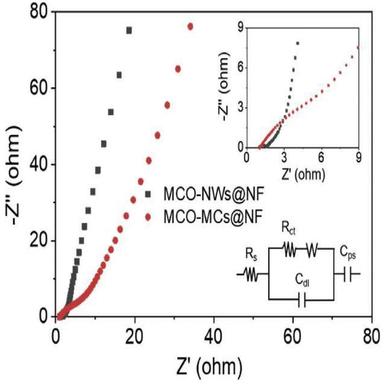
The Nyquist plots of binder-free MCO-NWs@NF and MCO-MCs@NF electrode materials, and the enlarged Nyquist plots and corresponding equivalent circuit diagram were presented in the inset.